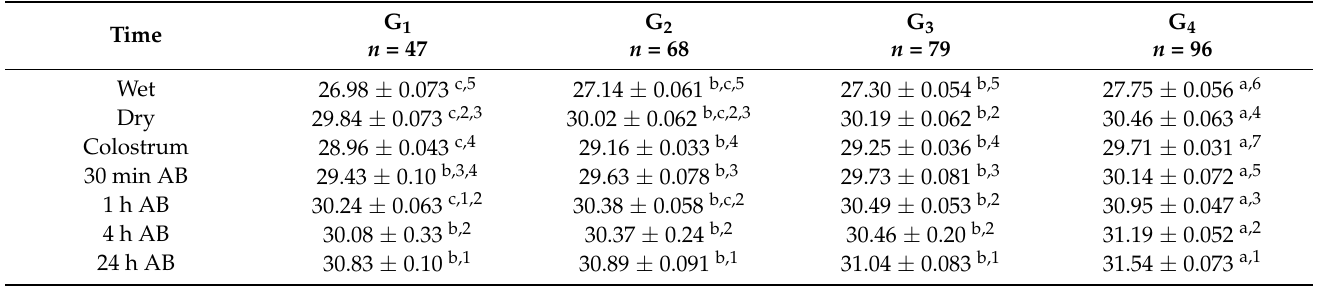
Table 3. Mean temperature ( ◦ C) of thoracic limb metacarpals (TLM) window at different times in newborn puppies from bitches classified into 4 groups according to its